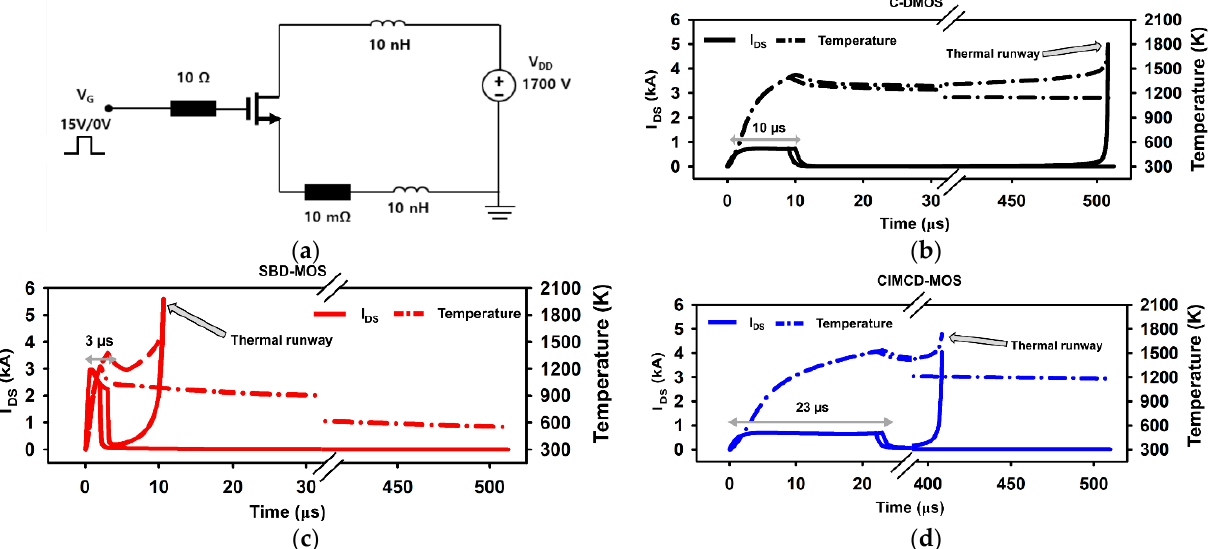
Figure 7. ( a ) Equivalent circuit diagram of short-circuit test. Short-circuit waveforms of ( b ) C – DMOSFET, ( c ) SBD – MOSFET, and ( d ) CIMCD – MOSFET.